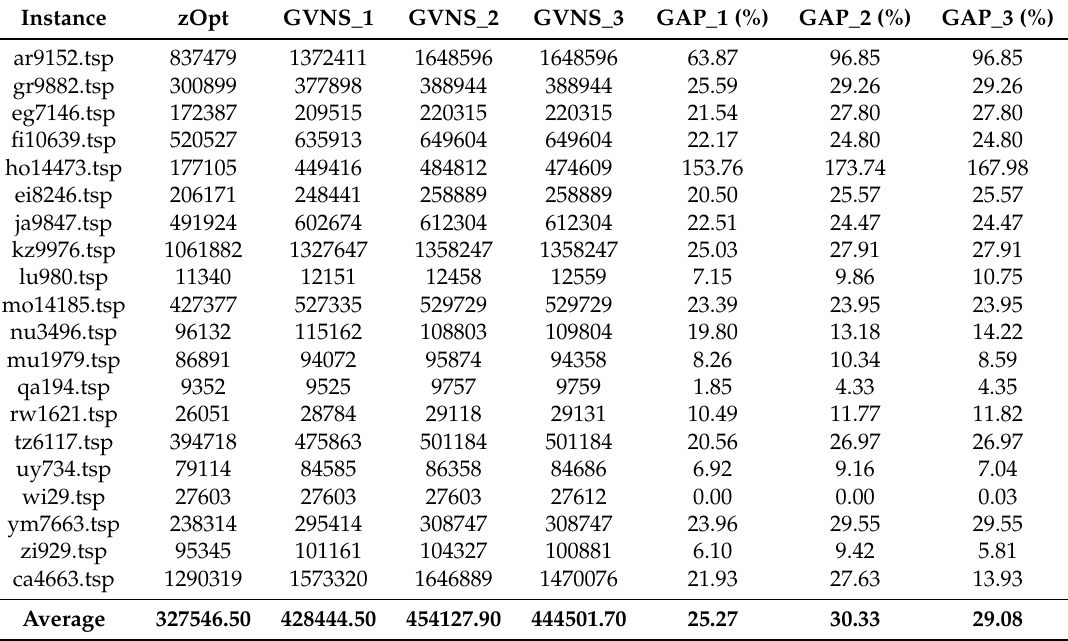
Table 12. Results using the Best Improvement search strategy and an execution time limit of 2 min.